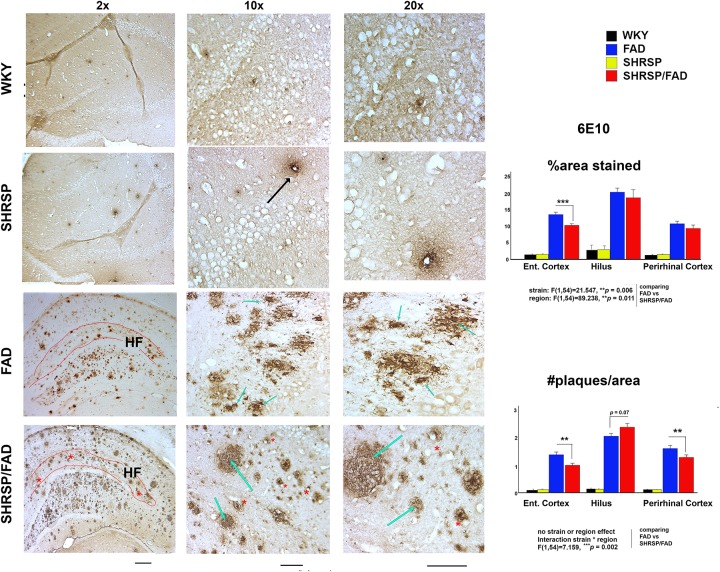
Neuritic Amyloid-β plaques in FAD rats become more diffuse with hypertension. Micrographs depicting Aβ (6E10) immunohistochemical staining of brain sections (hippocampus) from FAD (n = 11) and SHRSP/FAD (n = 9) rats are shown. No plaques were observed in WKY rats, while there was sparse vascular staining in the SHRSP rat (black arrow), unlike advance plaque pathology in the FAD and SHRSP/FAD groups. With the low magnification micrographs, more compact, neuritic plaques (black arrows) were observed in FAD rats, whereas plaques in the hippocampus of SHRSP/FAD rats rarely had compact cores and were more diffuse (blue arrows) and frequently associated with vessels (red asterisks). The highly vascularized hippocampal fissure is outlined in red. Although there was moderate staining for Aβ in the HF of FAD rats, the SHRSP/FAD rats showed extensive staining of plaques and vessels (red asterisks). Since there was negligible staining in the SHRSP and WKY groups, quantitative analysis was performed in the plaque-rich hilus, measuring Aβ plaque number and average percentage area only in the FAD and SHRSP/FAD groups. Two-way ANOVA (region × strain) of percent area and count, showed significant region effects, which post hoc analysis revealed was due to higher plaque burden and count in the hilus. For percent area, there was also a significant main effect of strain and post hoc analysis showed that this was due to a reduction in plaques in the entorhinal cortex of SHRSP rats. For plaque count, two-way ANOVA showed an interaction between strain and region. Post hoc analysis showed significant reductions in plaque number in both the entorhinal and perirhinal cortices of SHRSP rats. Data represent means ± SEM. ∗p < 0.05, ∗∗p < 0.01; two-way ANOVA. Log transformation of data for percent area was also performed to establish homogeneity of variance.